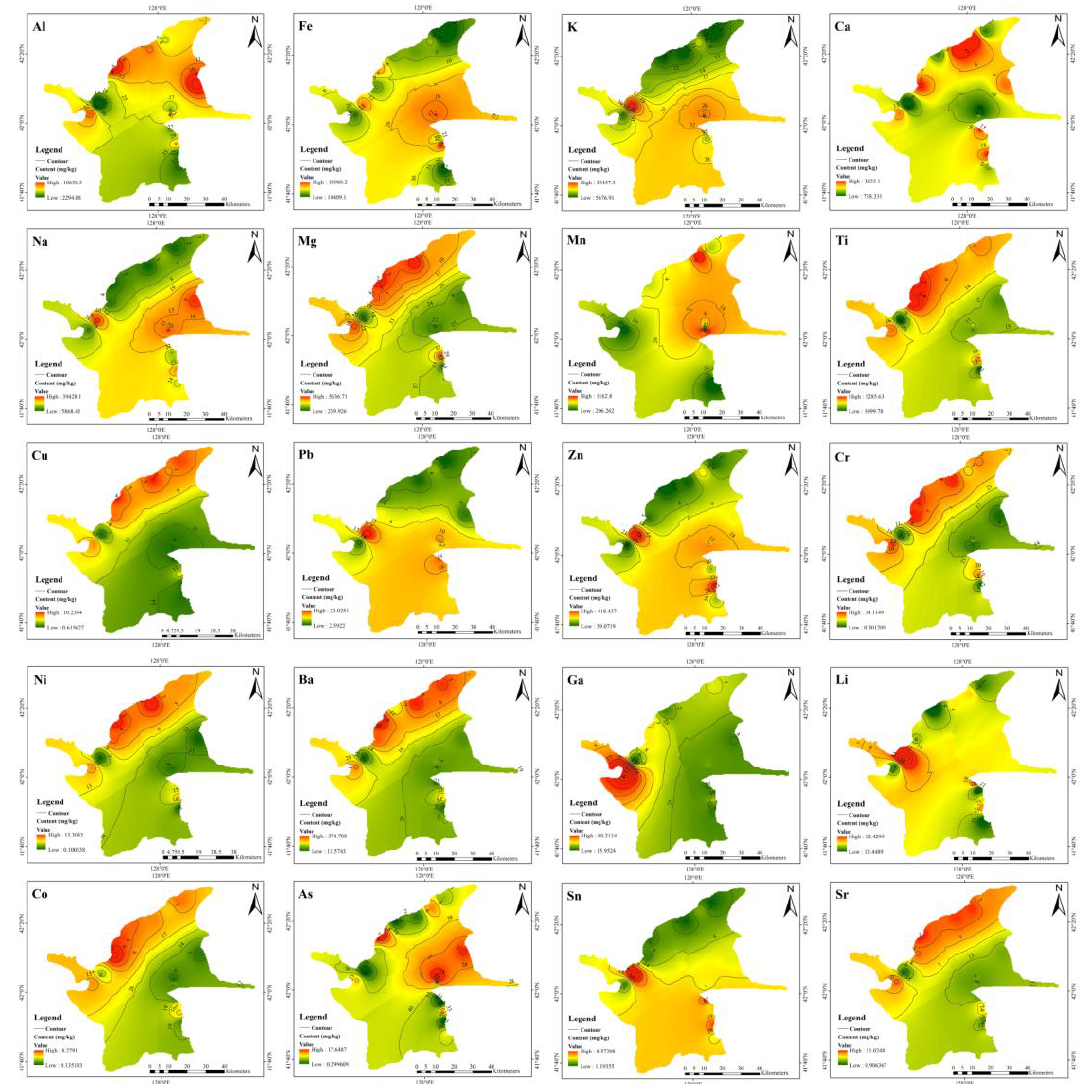
Figure 4. The spatial distribution of the 20 metals in Changbai Mountain. Table 2. Standard deviation (SD), coefficient of variance (CV) and one-way analysis of variance results of metal concentrations in volcanic soil and volcanic ash.